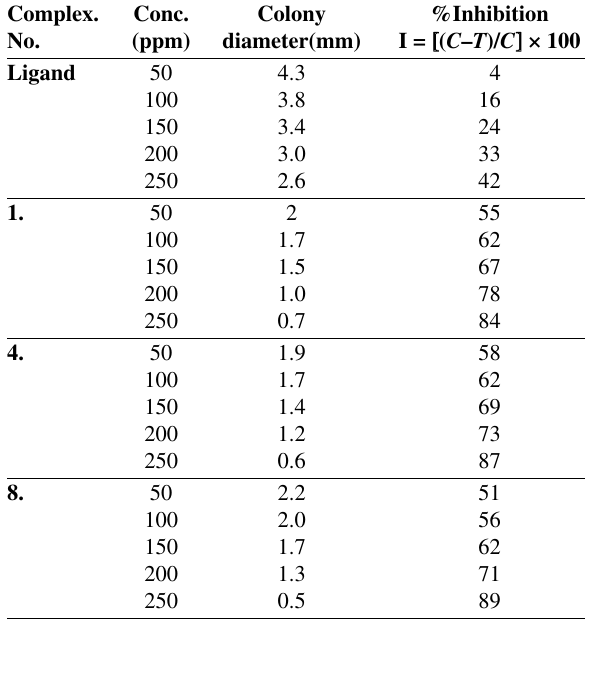
Table 2. In vitro evaluation of ligand and complexes against the fungus Fusarium oxysporum f. Sp. Capsici . Complex.